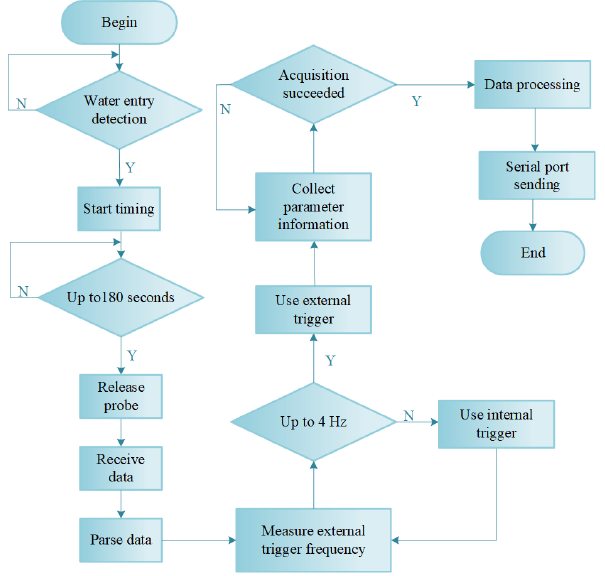
Figure 8. Software workflow diagram of the buoy board.